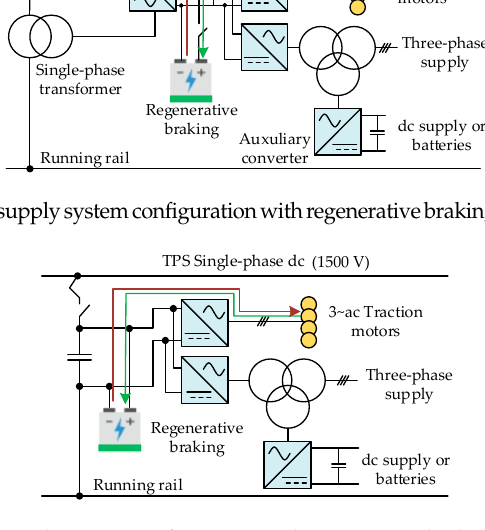
Figure 33. Traction power supply system configuration with regenerative braking: dc overhead catenary line.